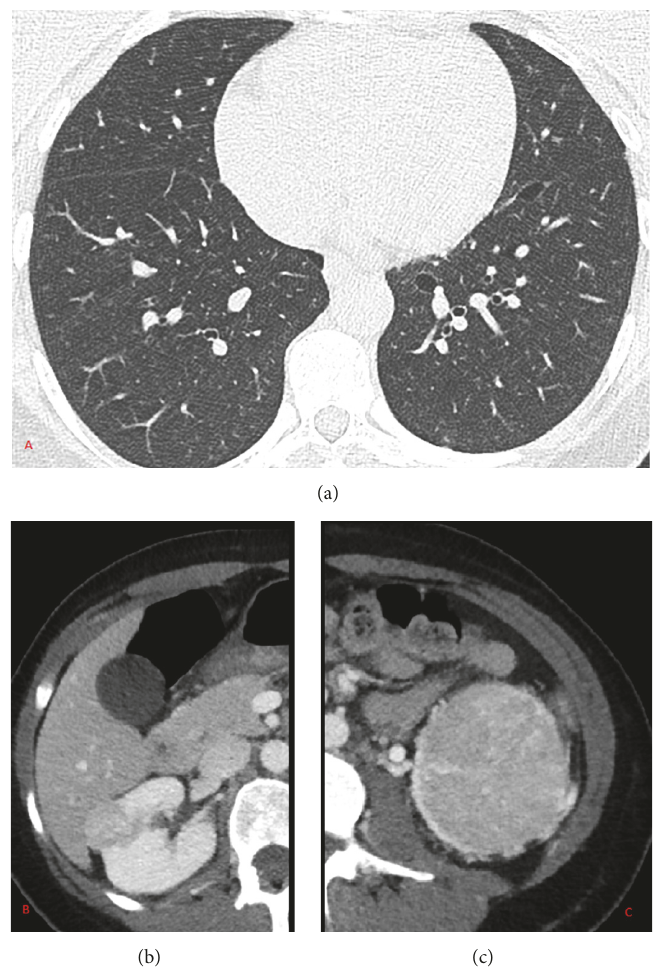
Figure 1: Image showing lung cysts (a), right kidney mass of 2.4 cm (b), and left kidney mass of 7.6 cm (c), which was later identified as an